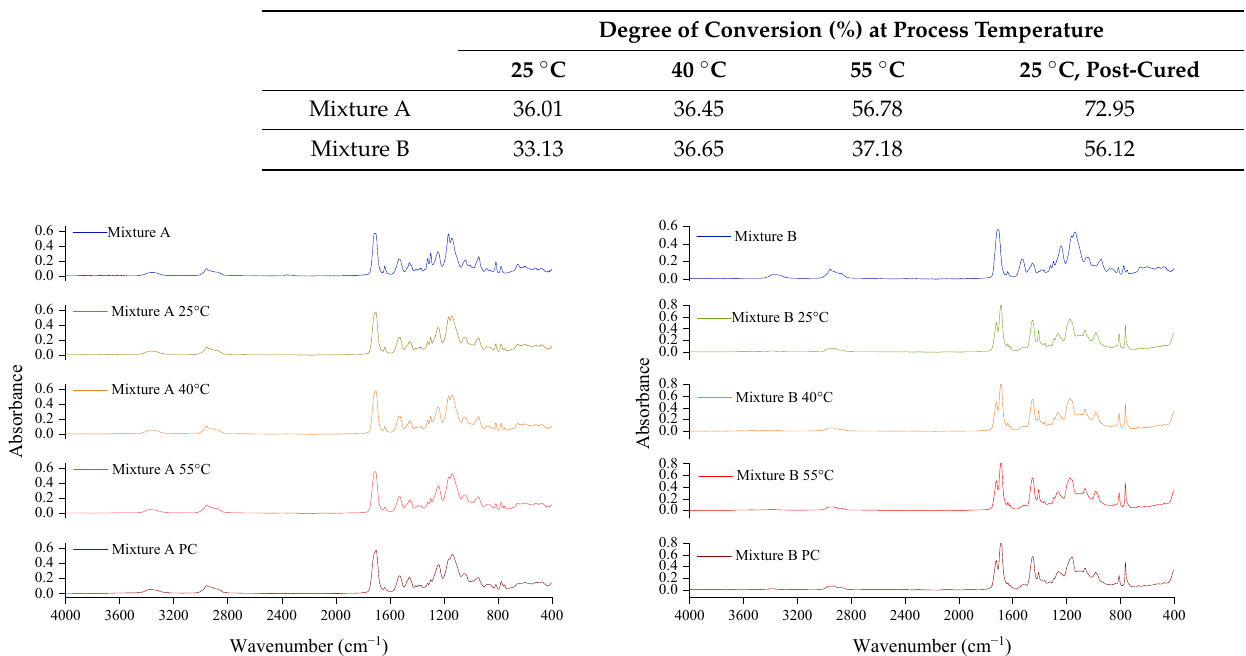
Table 4. The degree of conversion of Mixtures A and B at different process temperatures and after post-curing (as reference) calculated using the ATR spectrum.